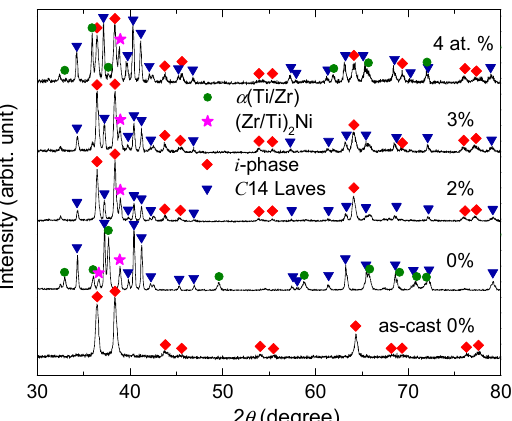
Figure 3. XRD patterns of as-cast (Ti 35.2 Zr 43.8 Ni 21 ) 100 − x Ag x alloys cooled after heating up to 936 K in the DSC experiment, which were measured at room temperature. The i -phase, C 14 Laves, α (Ti/Zr), and (Zr/Ti) 2 Ni phases were marked by diamonds ( ◆ ), triangles ( ▼ ), circles ( ● ), and stars ( ★ ), respectively.